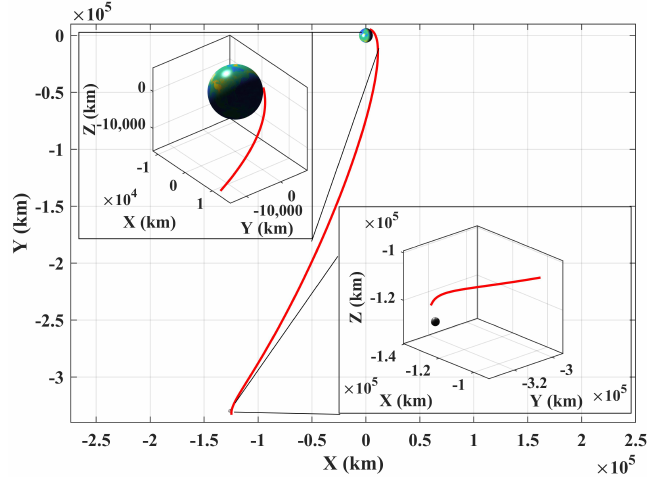
Figure 4. The optimal transfer trajectory of 3 October 2030. The trajectories near the Earth and the Moon are also shown in magnified form.